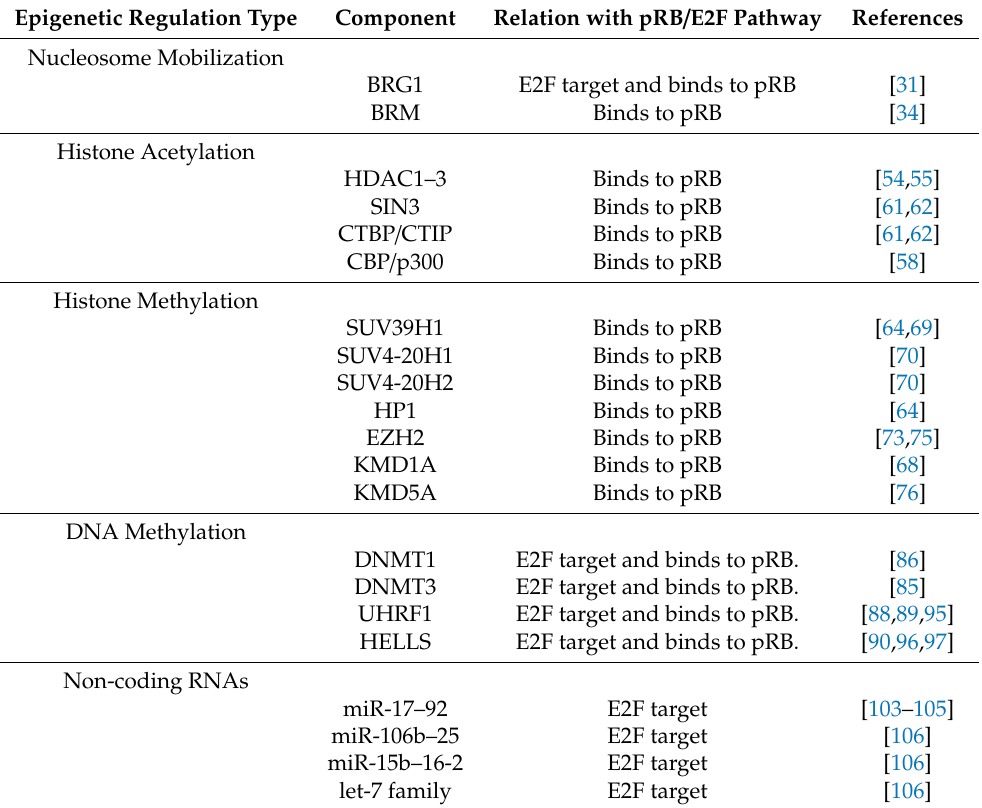
Table 1. Epigenetic regulators regulated by the pRB / E2F